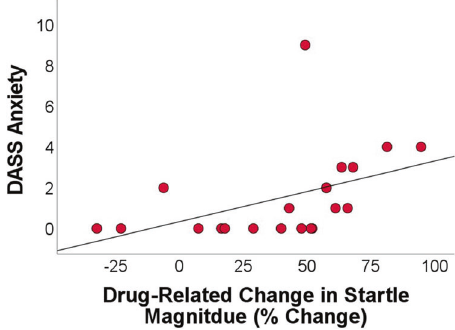
Fig. 2 Scatter plot displaying the signi fi cant association between current anxiety symptoms and drug-related change in startle magnitude during unpredictable threat. DASS Depression, Anxiety, and Stress Scale (21